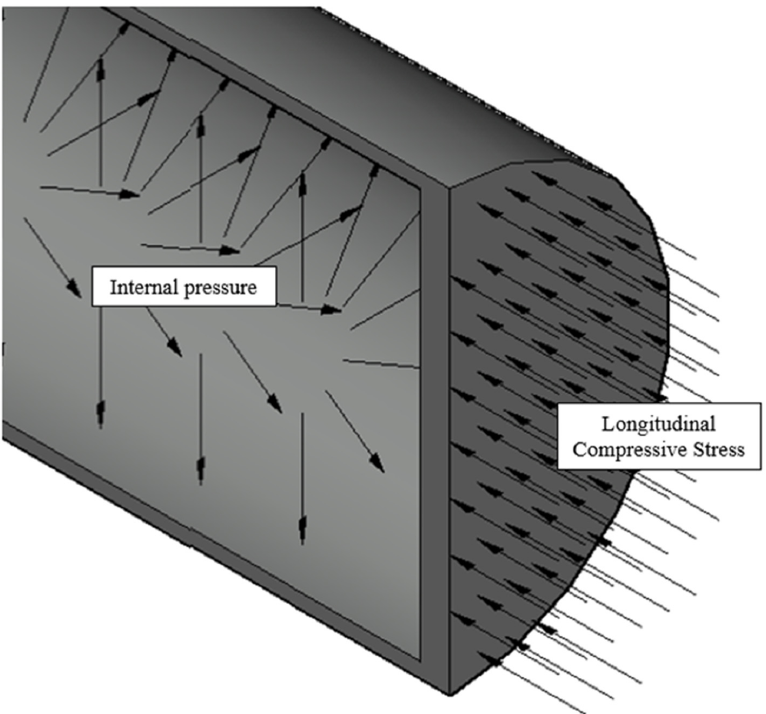
Figure 2. Internal pressure and longitudinal compressive stress applied in the model.